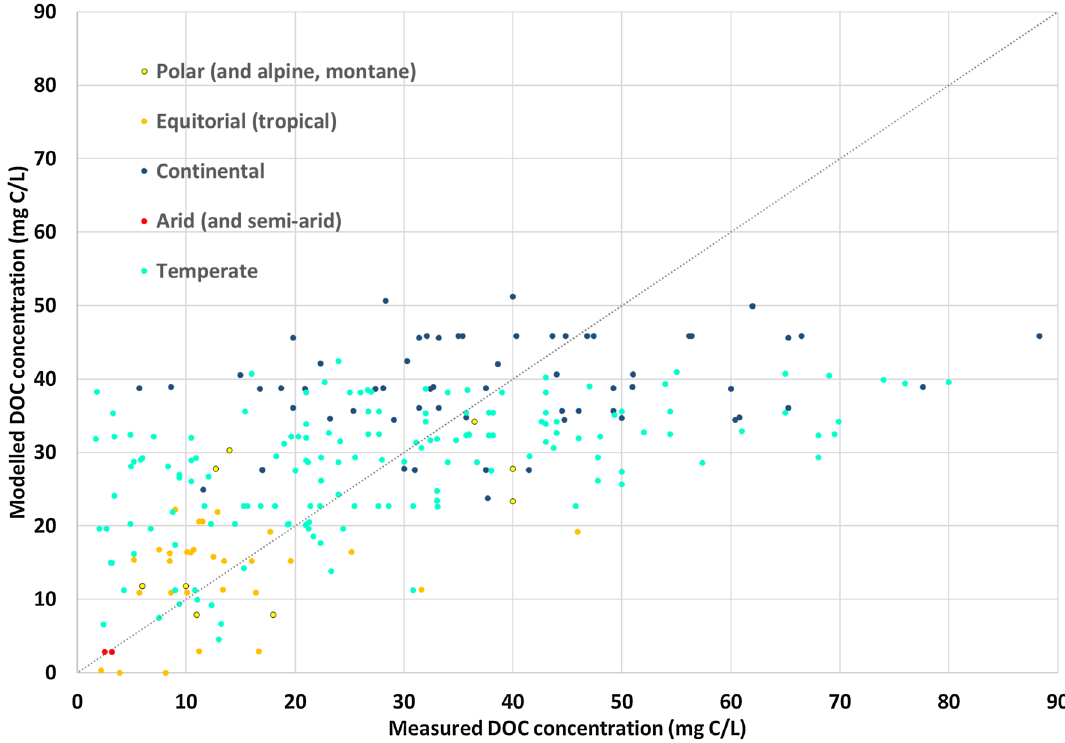
including soil classes in the regression analysis. Laboratory incuba- tion and B horizon data are excluded (see text). Entry #220 is also excluded as identified as a high leverage point in a partial regres- sion analysis using an added variable plot